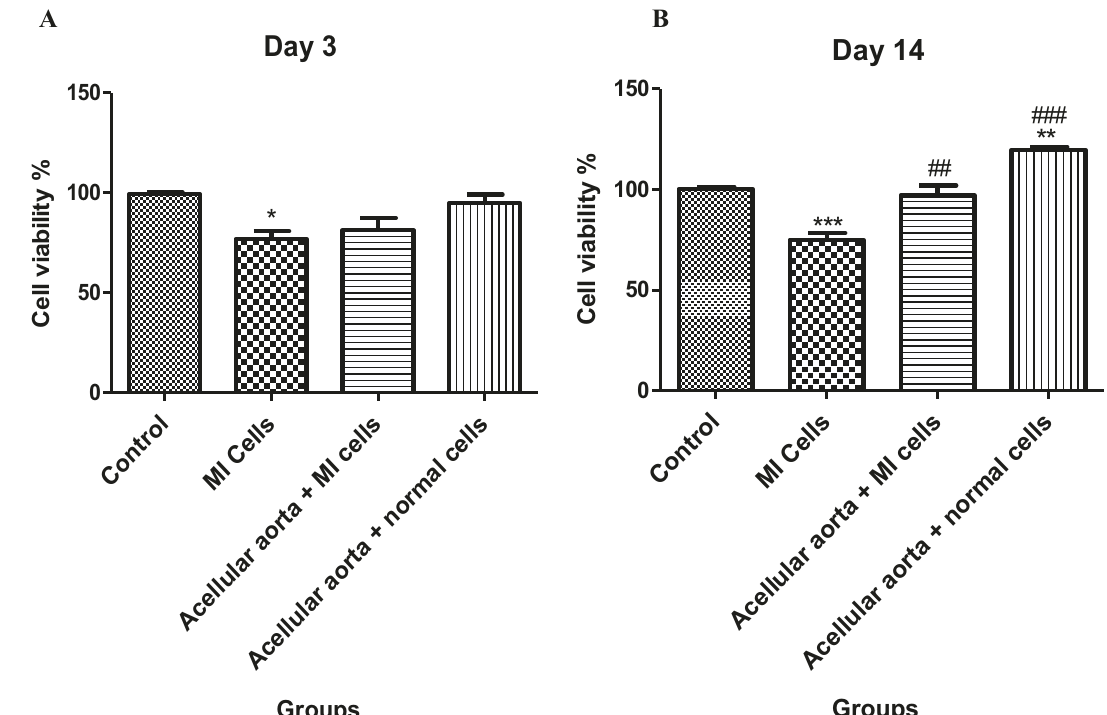
Fig. 2 MTT assay results on cell proliferation of 3D (acellular scaf- fold) and 2D cultured cells. A MTT assays were performed on the third day. B MTT assays were performed on the fourteenth day. Healthy cells and MI cells were grown in 3D culture compared to their respective 2D culture were measured at days 3 and 14. Control/ Healthy (normal) cells: cardiomyocytes isolated from healthy NMRI